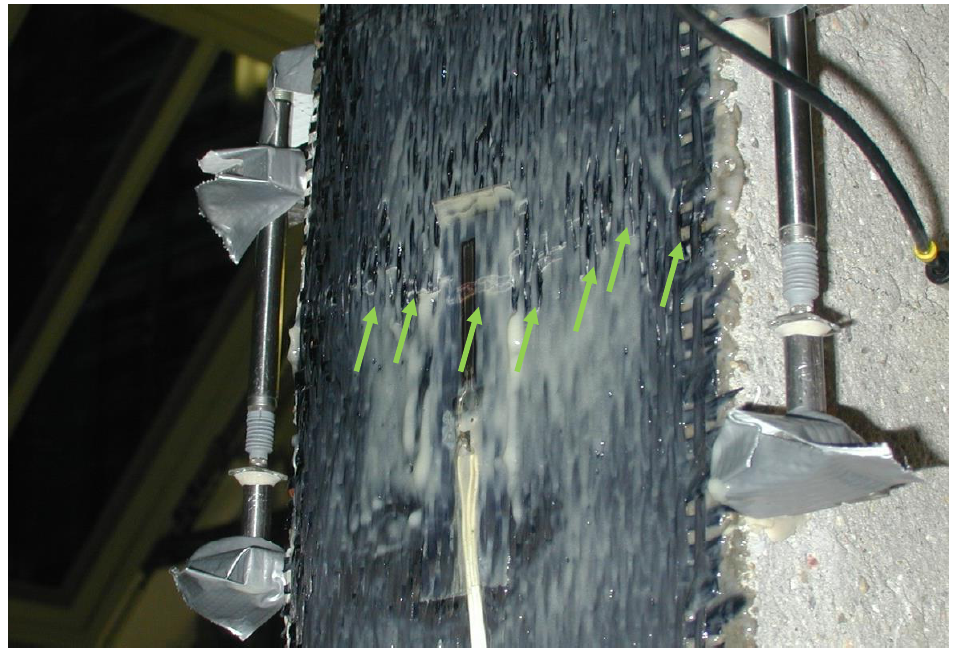
Figure 11. View of the soffit of the beam during fatigue test (green arrows indicate zones where the matrix of the CFRP is cracked).